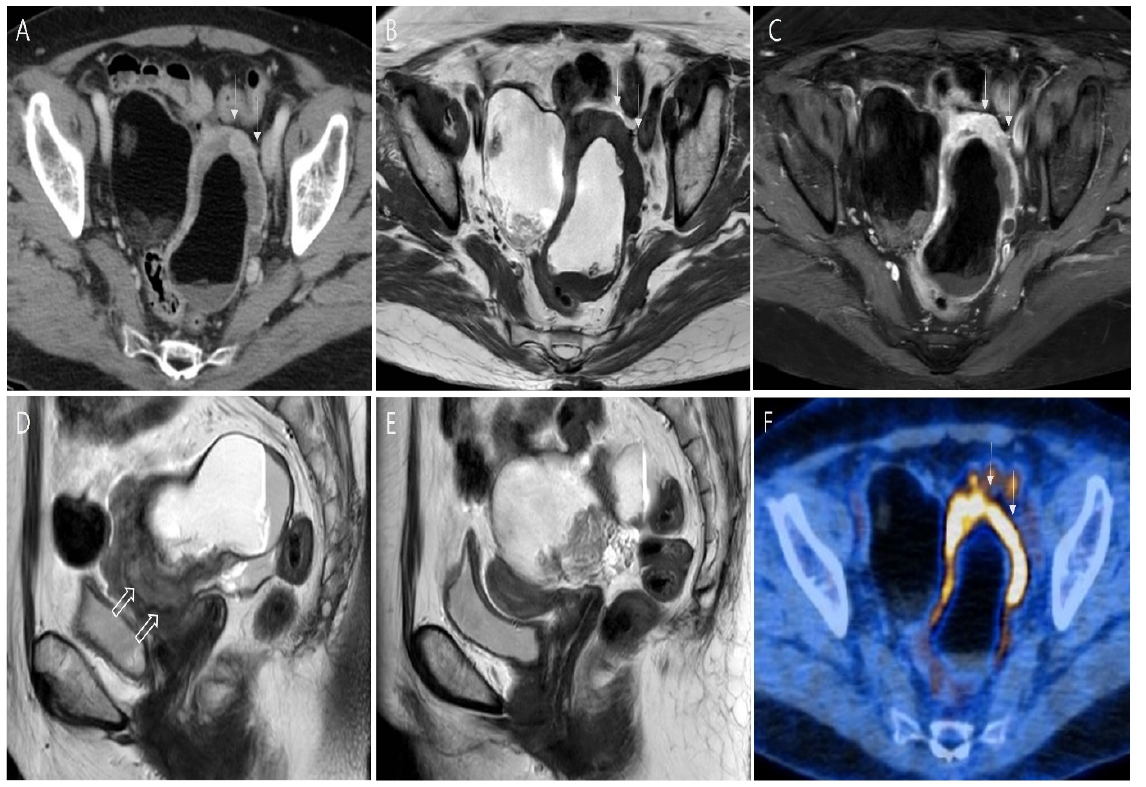
Figure 1. ( A ) Axial contrast medium-enhanced computed tomography showed a fat-containing mass in each adnexa. The left-sided mass had an eccentric thick rim (white arrows). Axial T1-weighted ( B ) and contrast medium-enhanced T1-weighted ( C ) magnetic resonance images (MRIs) showed suppression of high signal intensity of the fat component of both adnexal masses, which suggested that these masses were mature cystic teratomas. The eccentric thick rim of the left-sided mass (( B ), arrows) showed vivid enhancement. ( D ) Sagittal T2-weighted MRI showed irregular invasion of the uterus (arrows), which indicated malignant transformation. ( E ) Sagittal T2-weighted MRI showed normal signal intensity of the endometrium of the atrophied uterus. ( F ) Positron emission tomography/computed tomography demonstrated high fluorodeoxyglucose uptake (arrows) in the corresponding area of the left-sided mass.